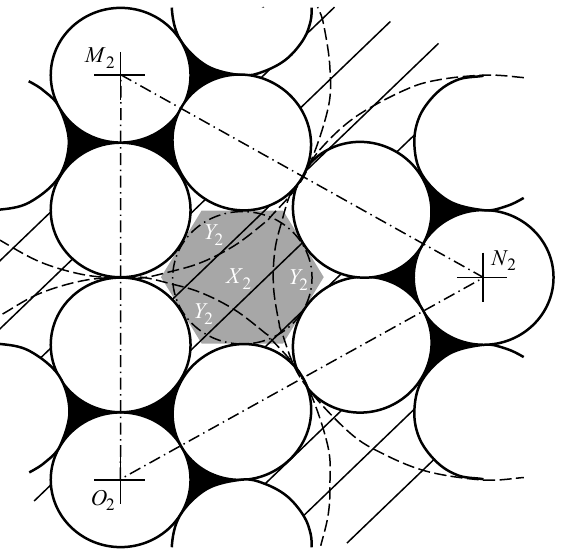
The area of pores of the second type in the form of curved hexagon (CH) S CH (shown in Figure 14 as a striped zone) is equal to the total area of the curved equilateral triangle X 2 and the three identical curved isosceles triangle Y 2 , that have the area of S CIT .